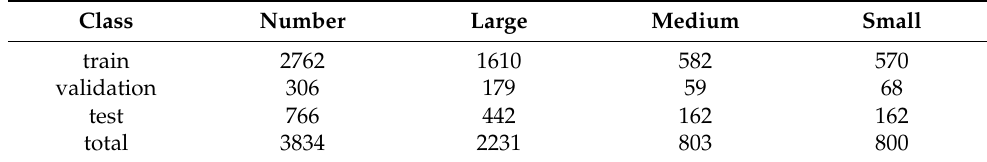
Table 2. The table of Drone-dataset’s